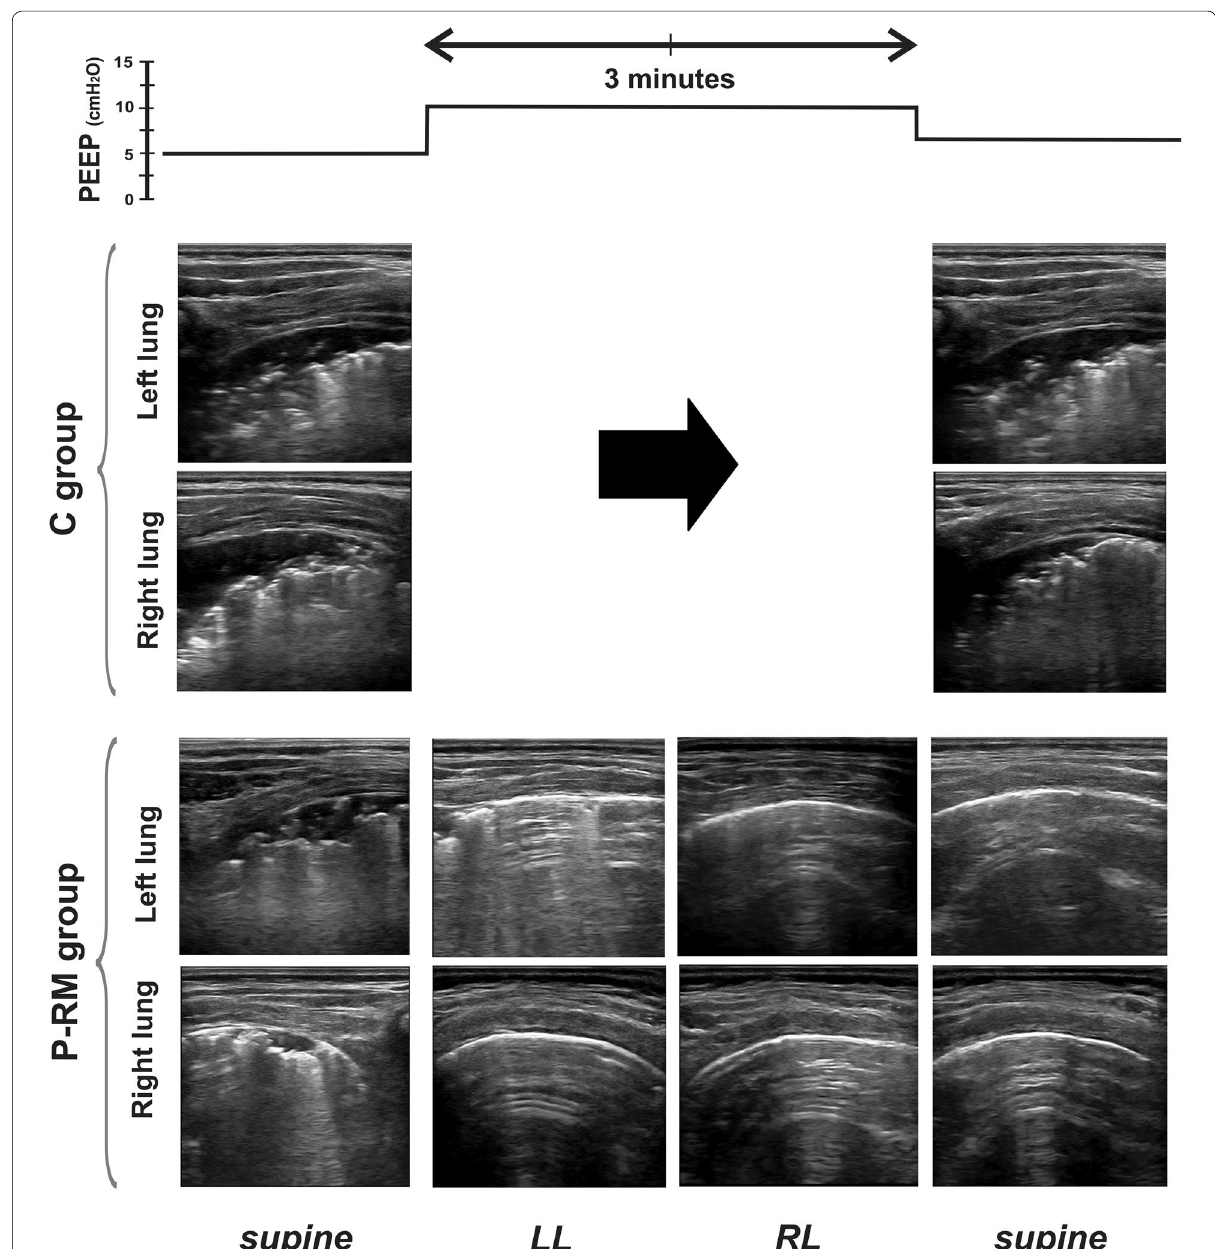
Fig. 4 Example of the protocol in one representative patient per group. LUS images were assessed in the posterior areas in supine (dorsal lung) and in the uppermost areas in the lateral positions (ventral lung). C group control patients, P-RM postural recruitment patients, LL left lateral, RL right lateral position. Note typical atelectasis with air bronchograms before the 10-PEEP maneuver in both groups and how only the P-RM resolved